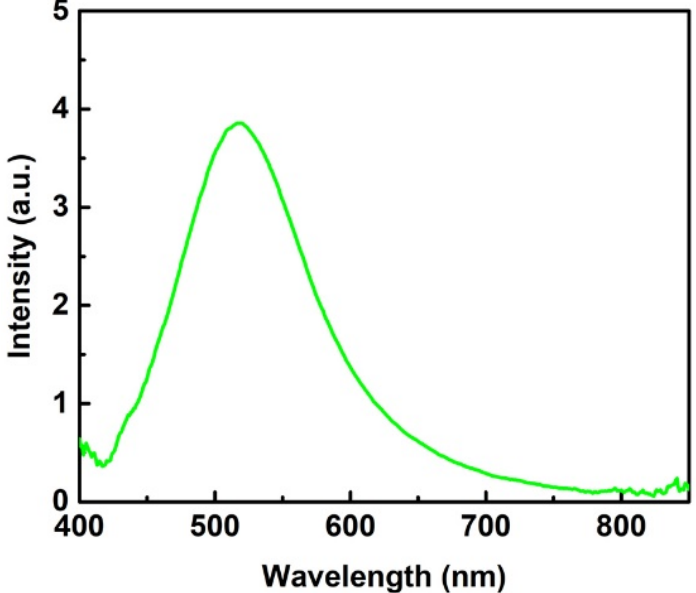
Figure 3. Scattering spectrum of a typical SERS substrate with 13 deposition